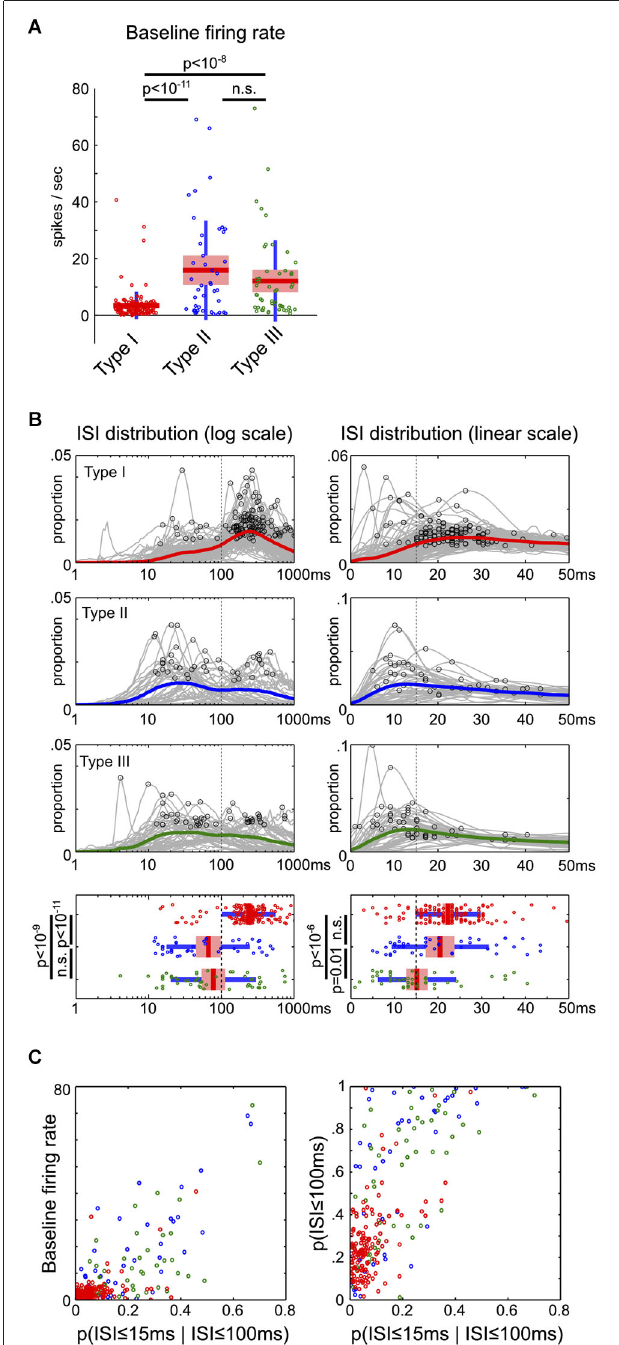
FIGURE 5 | Firing rate and inter-spike interval characteristics of BF neuronal types. (A) The baseline firing rates of Type-II and III neurons were significantly higher than Type-I BF neurons (ANOVA, post hoc t -tests). (B) ISI distributions on both log and linear scales for the three types of BF neurons. The mean ISI distributions for each type of neurons are shown in colored lines, with the peak of individual ISI distributions indicated by black circles. Significant differences in the peak of ISI distributions were found between the three types of neurons (ANOVA, log scale, F ( 2,232 ) = 35.27, p < 10 − 13 ; linear scale, F ( 2,232 ) = 12.74, p < 10 − 5 , post hoc t -tests). Type-I ( Continued